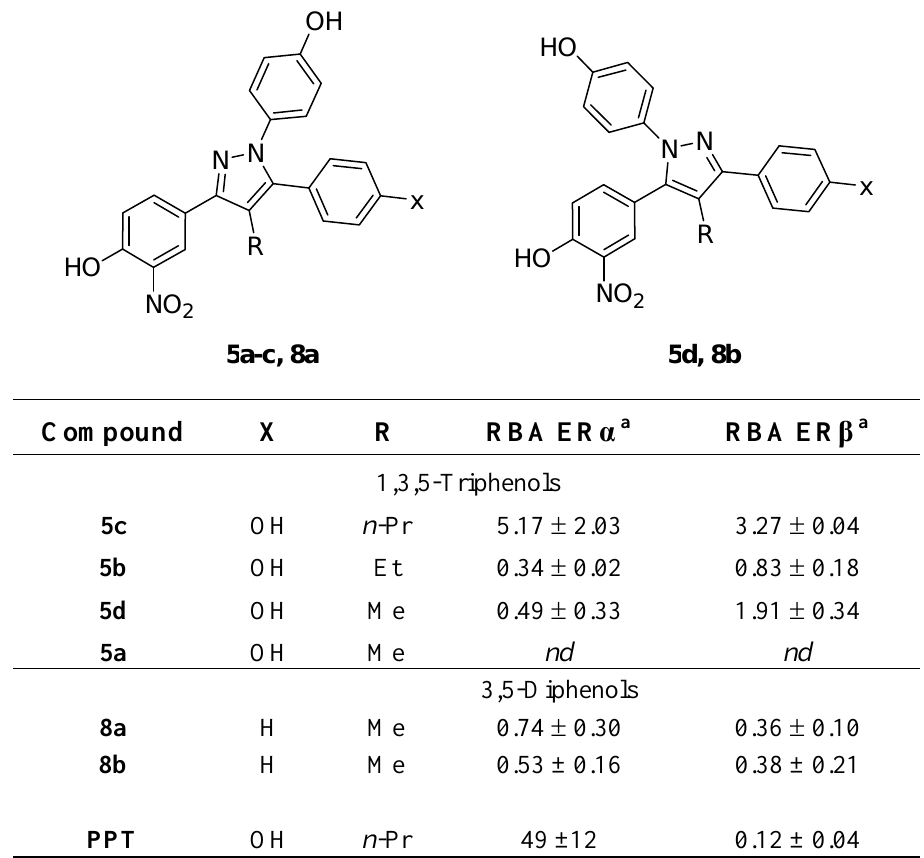
Table 1. Estrogen receptors (ER α and ER β ) binding affinities of Novel Triaryl Pyrazoles ( 5a-d, 8a,b